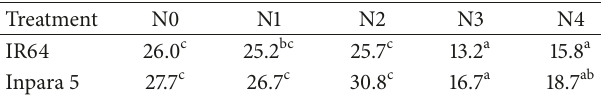
Table 4: Productive tiller numbers of two rice varieties and fertilizing treatment at condition of dirty water submergence stress.